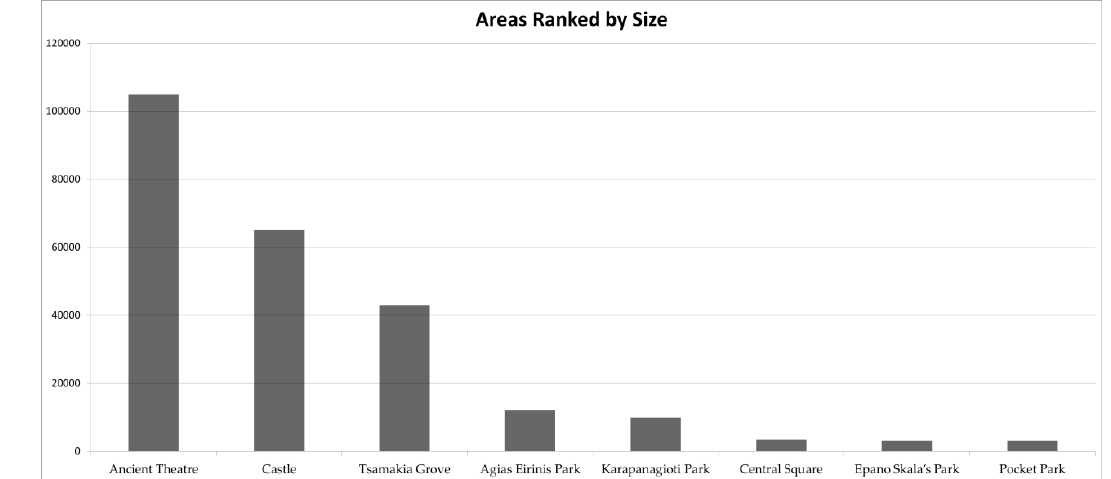
Figure 5. Potential quiet areas ranked by size measured in square